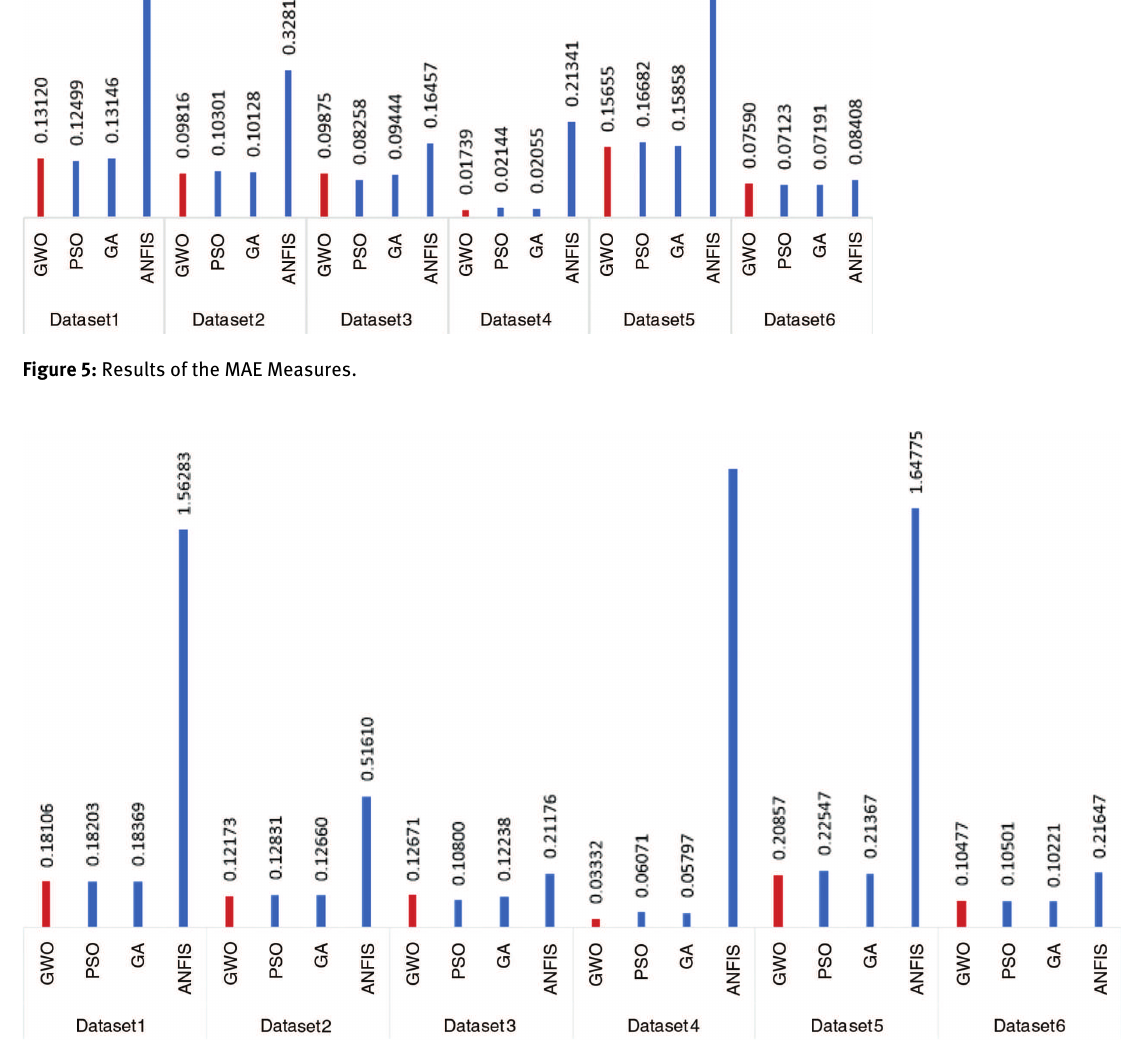
Figure 6: Results of the RMSE